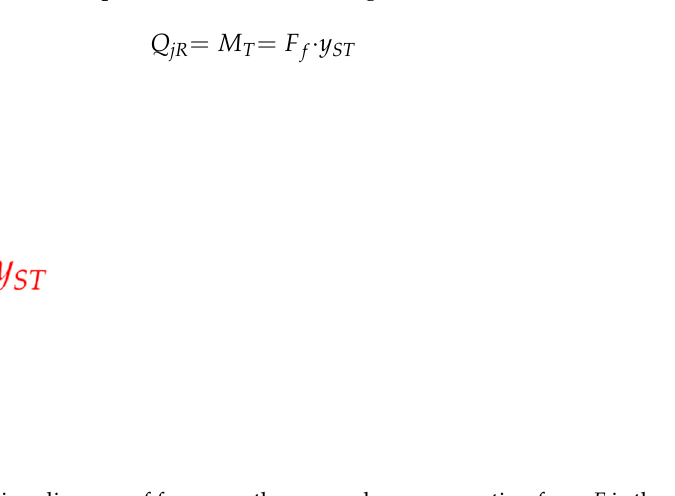
Figure 15. The distribution diagram of forces on the cam, where compaction force F is the normal of the frictional force F f on the cam curvature surface and the stamp, whereas the product of the frictional force F f and the arm y ST is equal to the frictional torque M T .